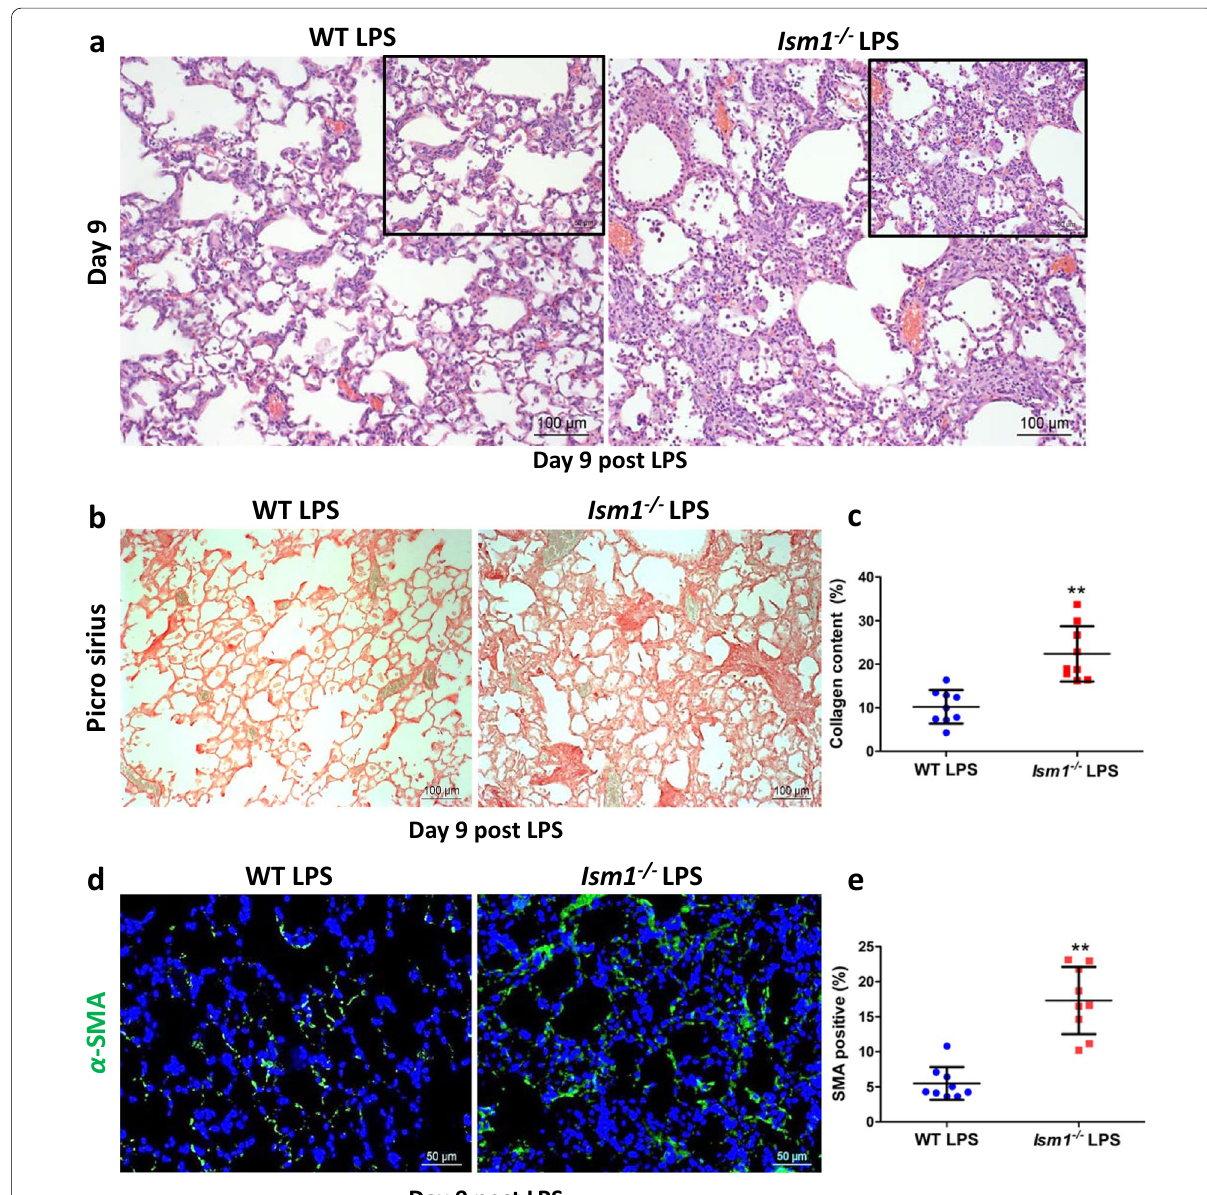
Fig. 5 ISM1 deficiency enhances lung fibrosis post LPS-triggered ALI. a Representative images of H & E stained lung tissue sections showing the extent of fibrosis in wild-type (WT) and Ism1 − / − mice at day 9 post LPS challenge. b , c Collagen deposition, detected by Picro-sirius staining, was higher in the lungs of Ism1 − / − mice as compared to those of WT mice. d , e Increased presence of contractile myofibroblasts within fibrotic foci (detected by α-SMA staining) in Ism1 − / − lungs as compared with those of WT. ** represents p < 0.01. n microscopic fields per section were